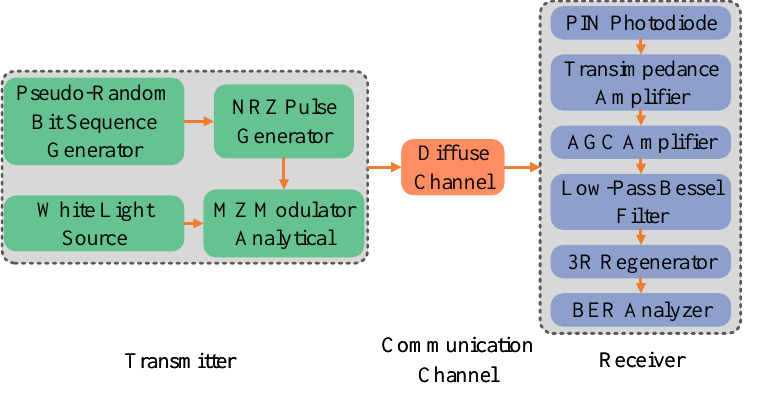
Figure 2. Simulation diagram.